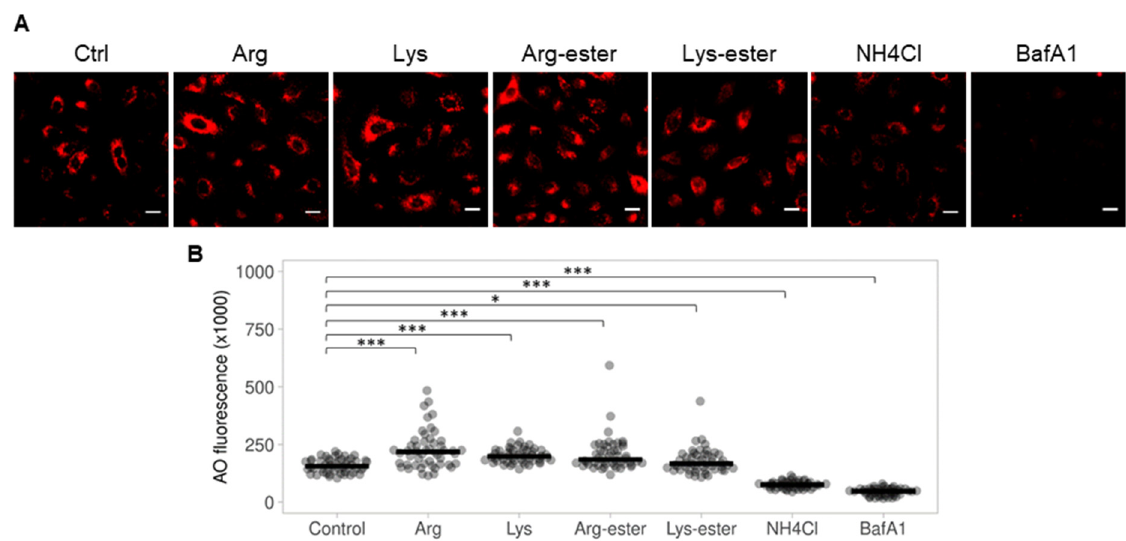
Figure 6. Acridine orange staining of A549 cells following compound treatment for 1 h. Cells were treated with the compounds (10 mM), NH 4 Cl (20 mM), or bafilomycin A1 (40 nM) for 1 h and stained with 1 µ g/mL AO for 15 min. ( A ) Acidic vacuoles (orange-red) were observed using fluorescence microscopy. Scale bar = 100 µ M. ( B ) Red fluorescence from 50 cells were calculated and plotted using ImageJ and PlotsOfData, respectively. Black horizontal lines represent the medians ± 95% confidence intervals. *, p < 0.05; and ***, p < 0.001 compared with controls.